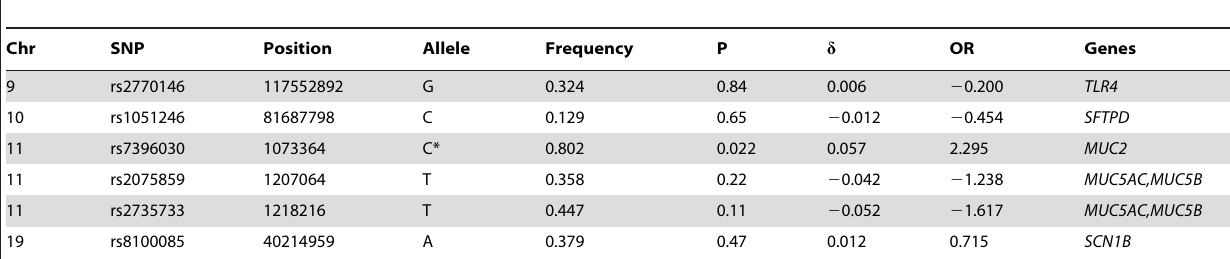
Table 4. GDT association results for SNPs in Table 3 genotyped in the Caucasian subjects from the replication sample.